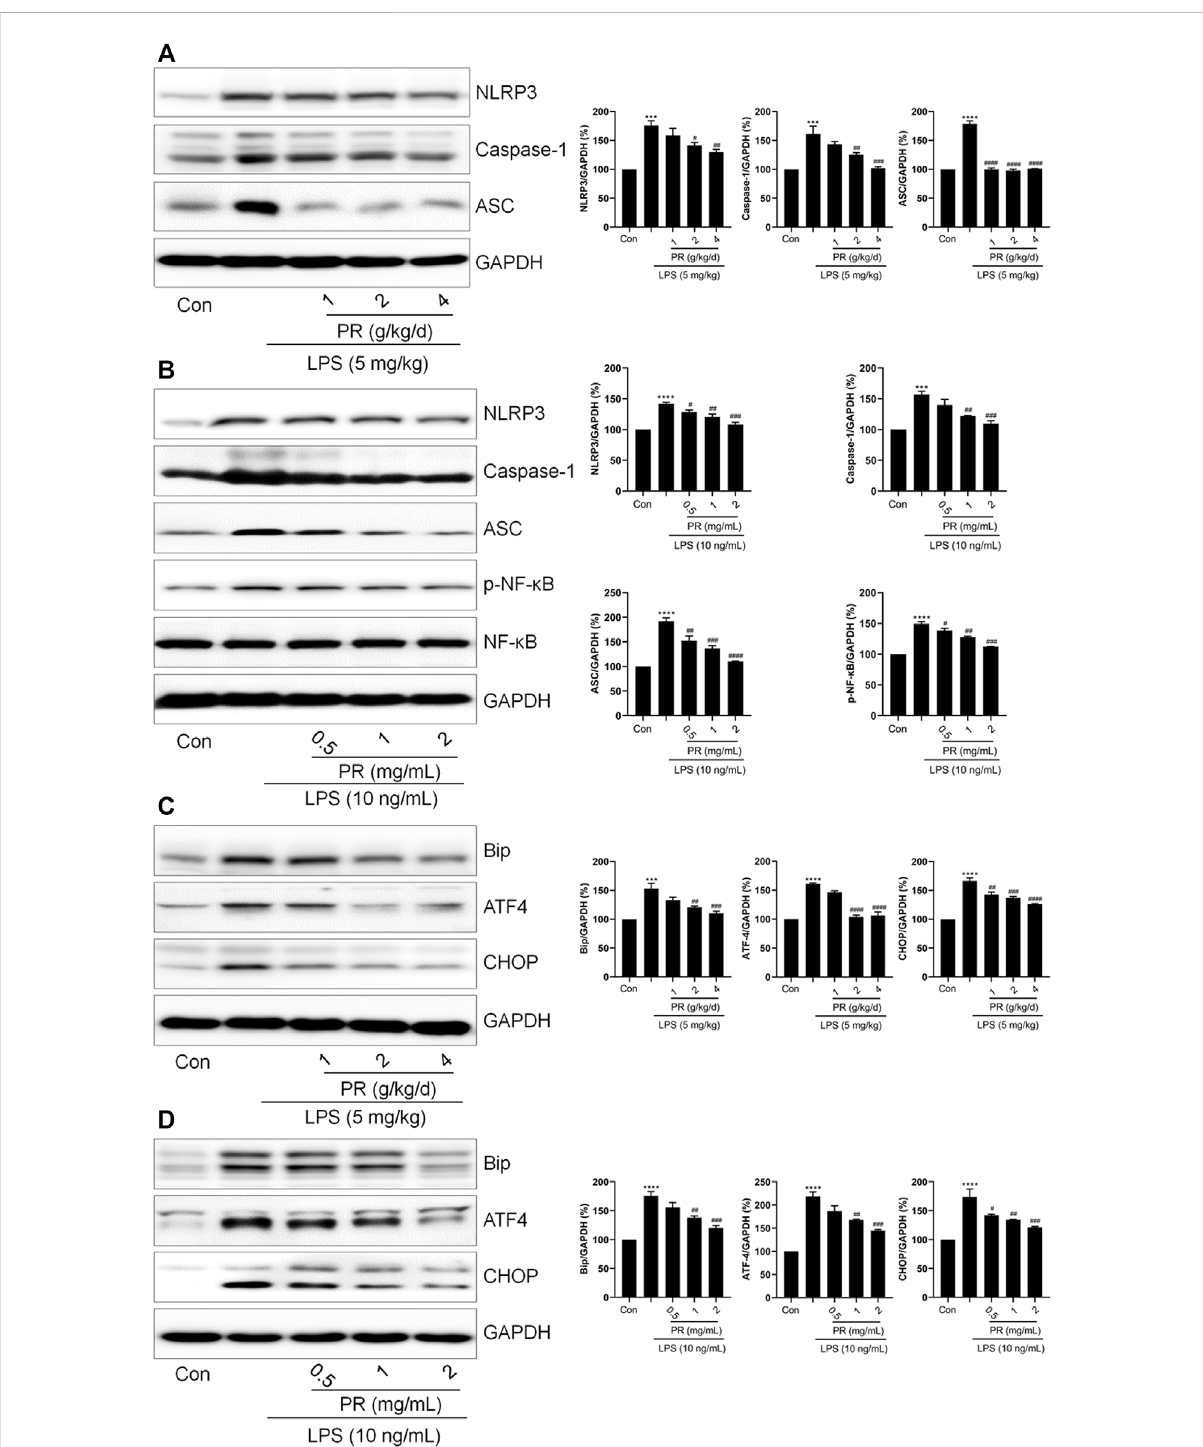
FIGURE 3 PR inhibits LPS-induced ER stress and NLRP3 in fl ammasome activation. (A) The expressions of IL-1 β , NLRP3, Caspase-1, and ASC in the lung tissueofmiceweredeterminedbyWesternblot( n =3). (B) RAW264.7cellswerechallengedwithLPSandtreatedwithPRfor12 h.Theexpressionsof IL-1 β ,NLRP3,Caspase-1,andASCinRAW264.7cellswereexaminedbyWesternblot.( n =3). (C) TheexpressionlevelsofATF4,Bip,andCHOPinlung tissue were detected by Western blot. (D) RAW264.7 cells were challenged with LPS and treated with PR for 12 h. The expressions of ATF4, Bip, andCHOPinRAW264.7cellsweremeasuredbyWesternblot( n =3). (E) IntracellularCa 2+ contentwasdetectedwithFluo4-AM.Scalebar=100 μ m. (F) After 12 h LPS treatment with/without 4-PBA co-treatment, the expressions of Bip, ATF4, and NLRP3 were detected by Western blot ( n = 3). *p < 0.05 , **p < 0.01 , ***p < 0.001 , ****p < 0.0001 vs. Control groups ; #p < 0.05 , ##p < 0.01 , ###p < 0.001 , ####p < 0.0001 vs. LPS-treated